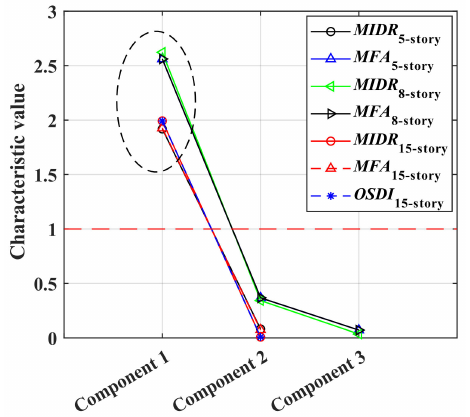
Figure 13. Characteristic values of different